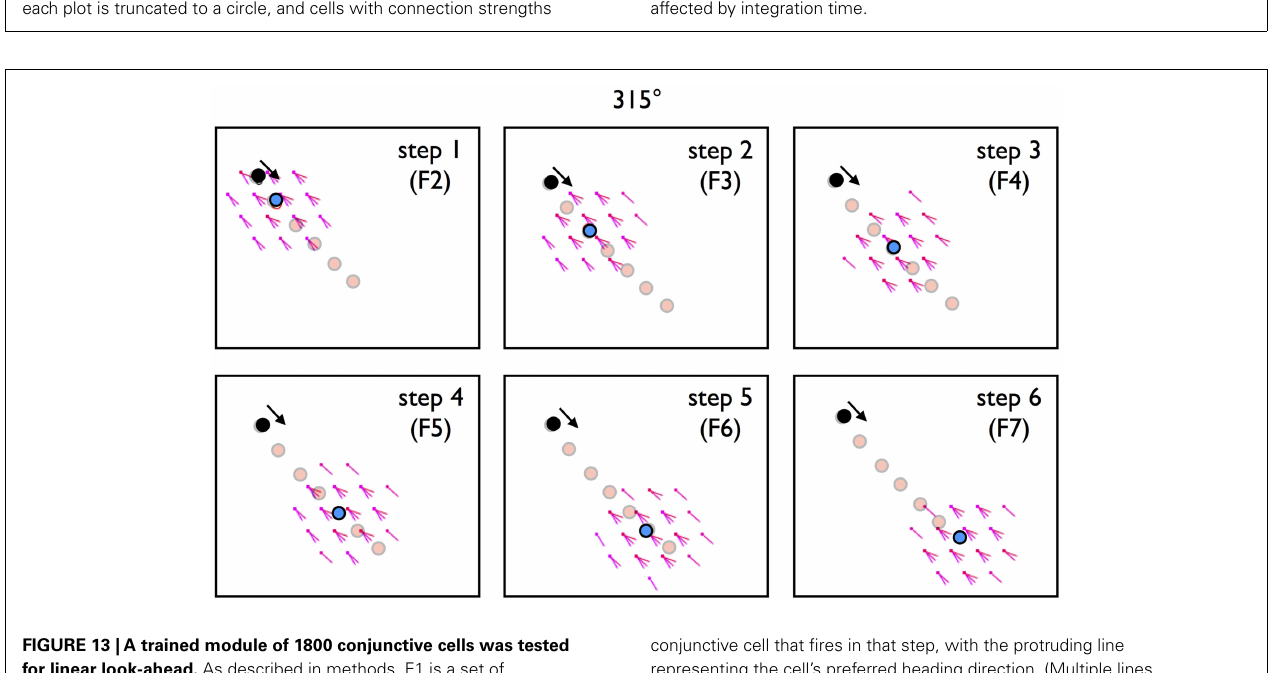
FIGURE 12 | Effects of pre-synaptic spike window and spike-time dependent plasticity (STDP) patterns on connection strength. The top row uses the hit ratio synaptic weighting method while the bottom row uses a STDP method. All plots are for an identical 60minTraining session. The preference angle for all cells is 60˚, so a perfect displacement will be at a 60˚ angle from center. Each plot depicts the centroid (center of mass) for the strength of connection between one neuron and 48 other neurons with the same heading preference (60˚).The set of depicted weightings for each plot is truncated to a circle, and cells with connection strengths